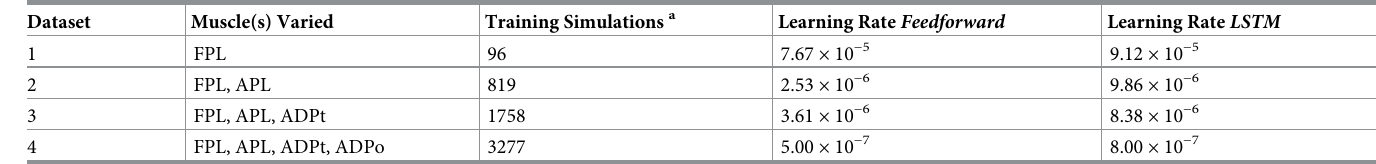
Table 2. Muscles varied, training simulations, and final learning rates for each neural network model across datasets. Dataset Muscle(s)